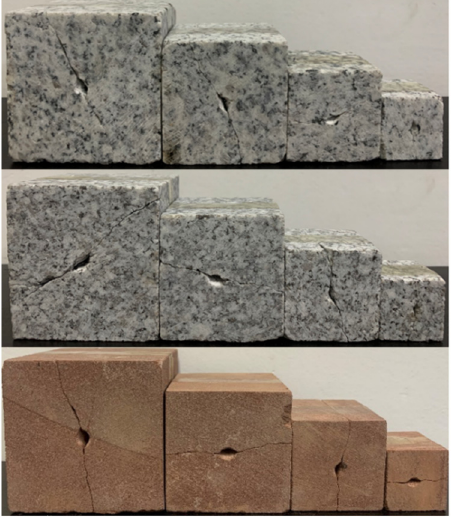
Figure 4. Images of point load damage in the three rock samples.